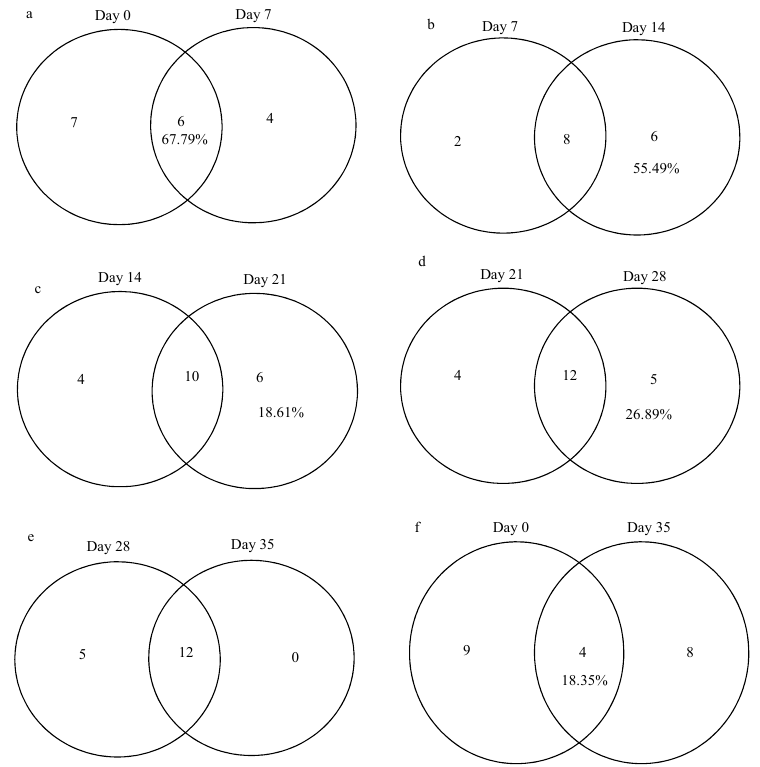
Figure 4. Comparisons of major bacteria (>1%) at the genus level between day 0 and 7 ( a ); day 7 and 14 ( b ); day 14 and 21 ( c ); day 21 and 28 ( d ); day 28 and 35 ( e ); and day 0 and 35 ( f ) during the SSF of PFPT.